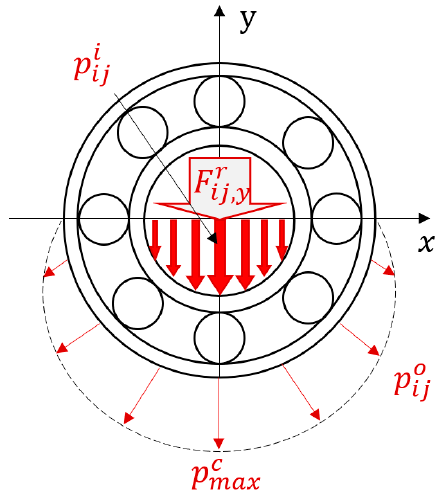
Figure 8. Force distribution on loaded balls.